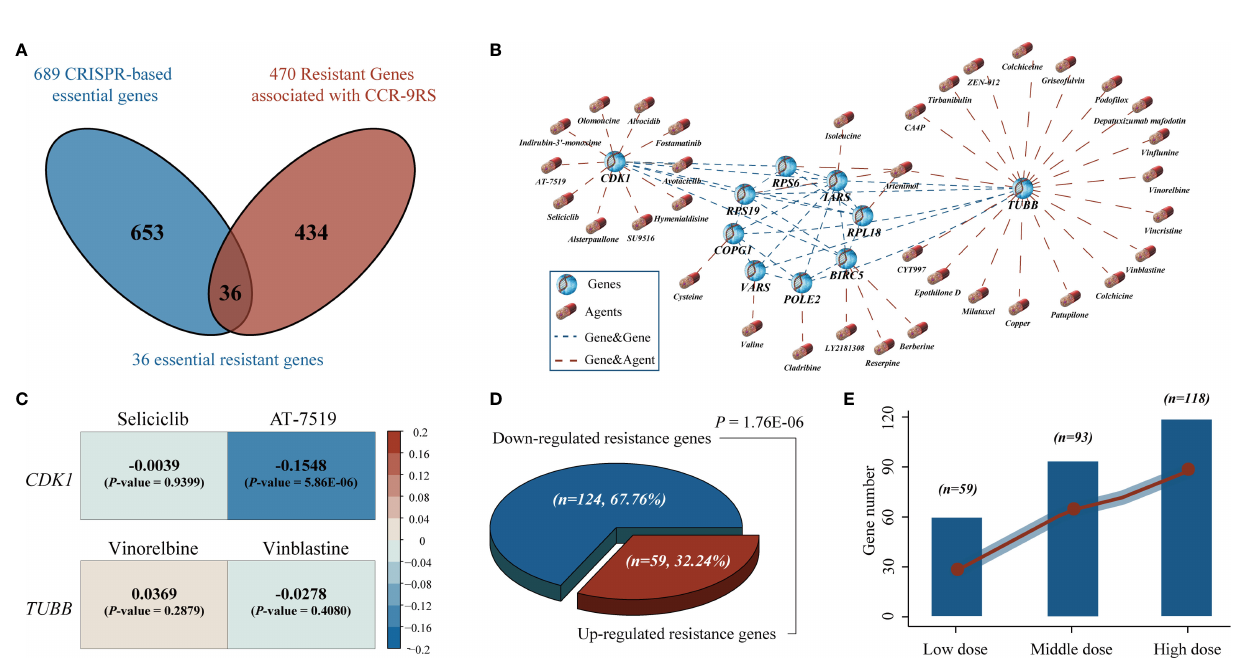
FIGURE 6 | Identi fi cation of potential therapeutic agents for the patients resistant to CCR treatment. (A) Venn diagram of the resistant genes identi fi ed in tumor tissues (NSCLC-Radiogenomics dataset) and essential genes identi fi ed by CRISPR dataset. The blue circle represents the essential genes screened by CRISPR dataset and the red circle represents the resistant genes signi fi cantly positively associated with the resistant scores of the CCR-9RS in the NSCLC-Radiogenomics dataset. (B) A gene-agent network of essential resistant genes and candidate therapeutic agents using DrugBank database. The blue dotted line represents the signi fi cantly correlated essential resistant genes (Pearson correlation, FDR < 0.05, Figure S4 ) and the red dotted line represents the candidate therapeutic agents targeting essential resistant genes in DrugBank database. (C) The correlation analysis of four overlapped therapeutic agents corresponding to two essential resistant genes using GDSC cancer cell line dataset. (D) Binomial distribution for the down-regulated and up-regulated resistance genes induced by AT-7519. (E) The number of down-regulated resistance genes induced by AT-7519 in three dose groups (left to right: Low, Middle and